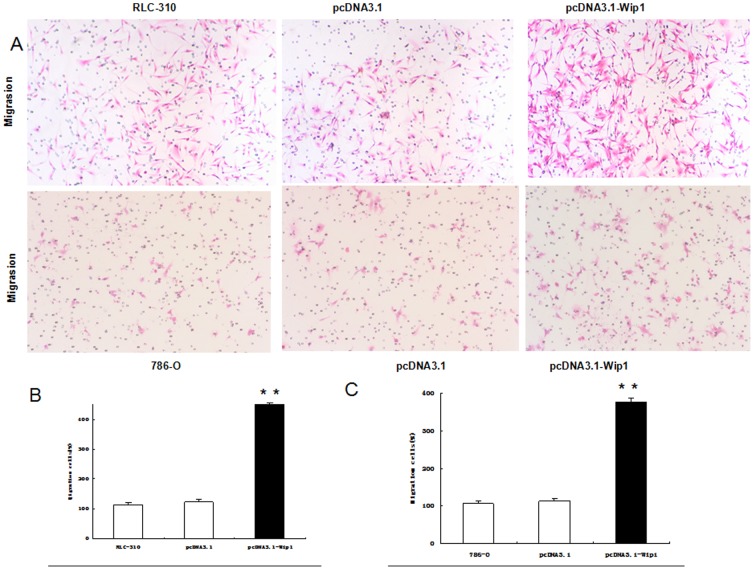
Overexpression of Wip1 augments the migration ability of RCC cells in vitro.A, Representative images of the migrate 786-O and RLC-30 cells in Matrigel invasion assays were taken at ×200 magnification. B, C: Numbers of the invaded 786-O and RLC-30 cells per microscopic field. Data are presented as the means ± SD from three independent experiments. * * p<0.001.